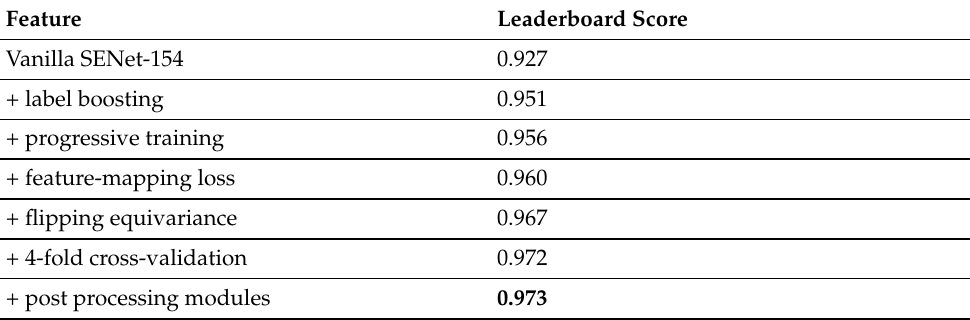
Table 2. Leaderboard scores. The private leaderboard is calculated with approximately 80% of the test data. Starting with a vanilla SENet-154 backbone, several training modules are integrated gradually. With all the processing modules, we were ultimately able to reach a score of 0.973, exceeding all other